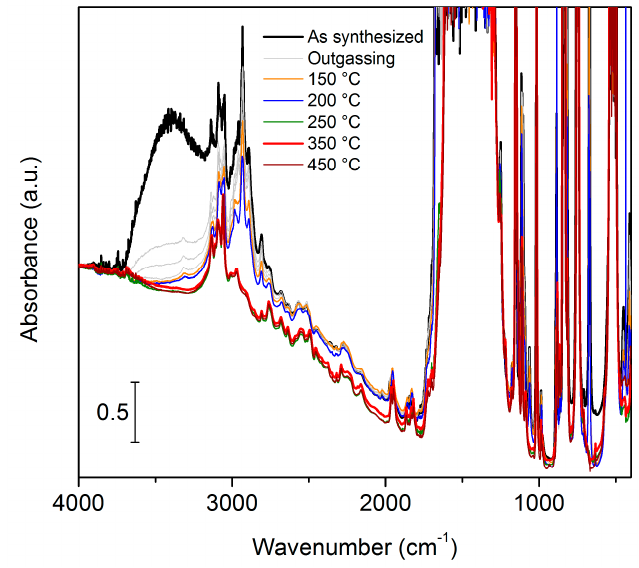
ff erent temperature in